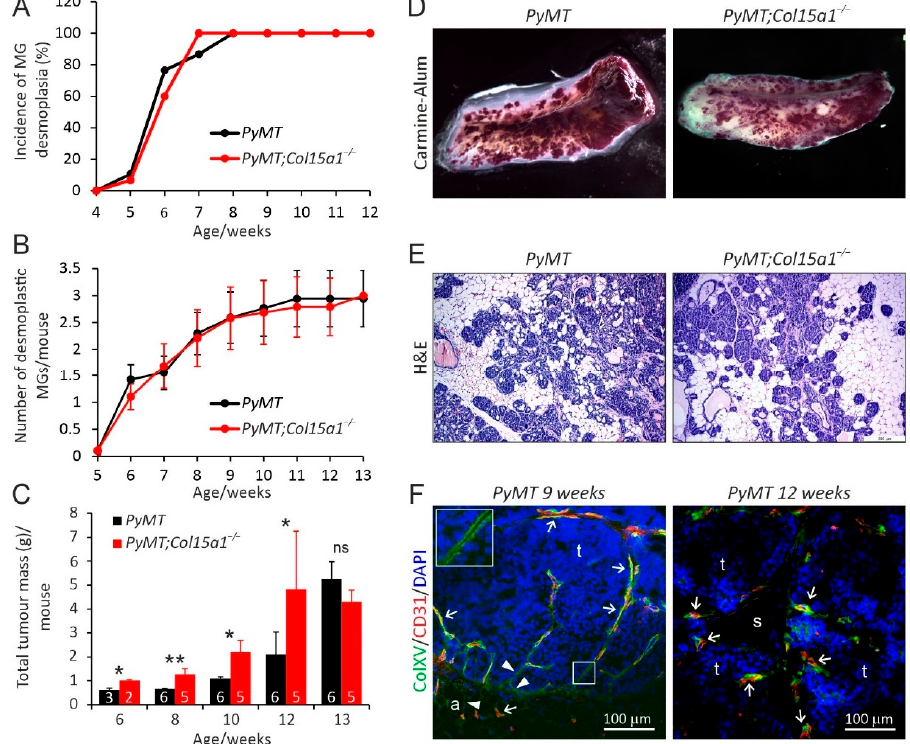
Figure 1. Mammary carcinogenesis in the wild-type MMTV-PyMT ( PyMT ) and ColXV-deficient PyMT; Col15a1 ‒ / ‒ mice. The incidence ( A ) and number ( B ) of desmoplastic mammary glands (MG) per mouse at the age of 4–13 weeks. Abdominal and thoracic MGs were palpated weekly. ( C ) Total tumour burden in the MGs of PyMT and PyMT; Col15a1 ‒ / ‒ mice at indicated ages, measured as total weight of the dissected four abdominal and two thoracic MGs. The numbers of mice included in the analyses are shown in the bars. ( D ) Representative images of Carmine Alum-stained whole mount prepa- rations of MGs at week 11, and ( E ) haematoxylin-eosin (H&E)-stained MG sections at week 6. ( F ) Representative images of ColXV and CD-31 double immunofluorescence staining in mammary tumours of control PyMT mice at the age of 9 and 12 weeks. ColXV localises in the BMs of tumour nests (arrowheads and magnification in insert) and in vascular BMs, where it often overlaps with the CD-31 signal (arrows). a, adipocyte; s, tumour stroma; t, tumour tissue. Fluorescent sig- nals: ColXV, green; CD-31, red; nuclei, DAPI, blue. The scale bar in E is 200 µm and in F 100 µm. The error bars in B and C indicate s.e.m. * p < 0.05; ** p < 0.01; ns, not significant.